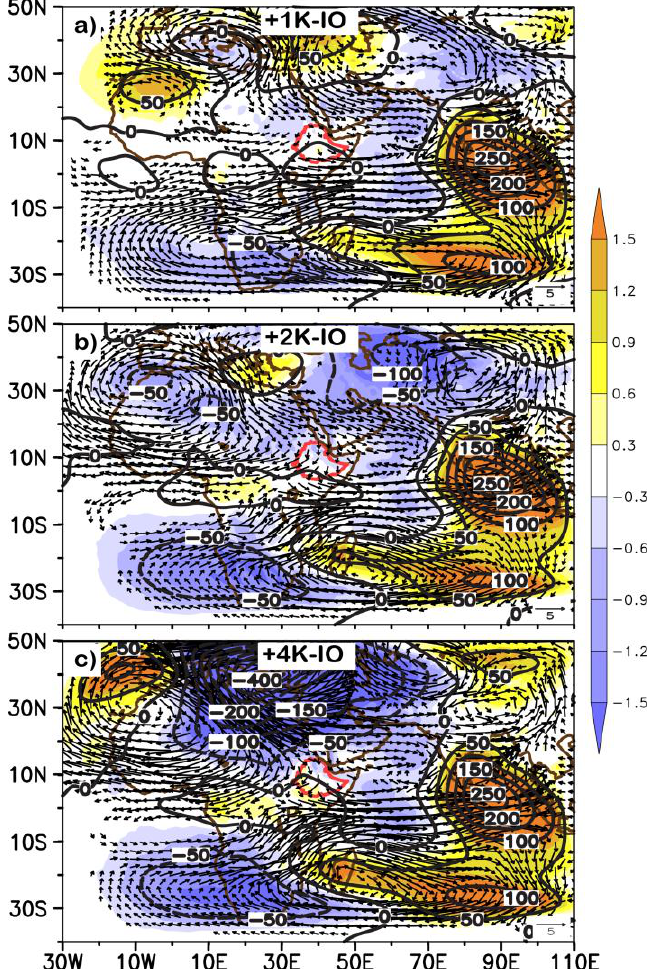
Figure 13. Circulation changes from CNTRL at 150 hPa averaged over July-August for SST anomaly (SSTA) forcing of ( a ) +1K, ( b ) +2K, and ( c ) +4K over the Indian Ocean (IO; 40°S–25°N, 30°–110°E). Each panel shows differences in horizontal winds (vectors; m·s −1 , magnitude scale in lower right corner), temperature (shading; K, color scale at right), and geopotential height (contours; gpm) between the perturbed SSTA forcing experiments and CNTRL. Differences of geopotential heights are contoured every 50 gpm. Anomaly vectors are plotted for resultant magnitudes of at least 1 m·s −1 only. The border of Ethiopia is delineated in solid red line. See Table 1 for description of experiments. See Table 1 for description of